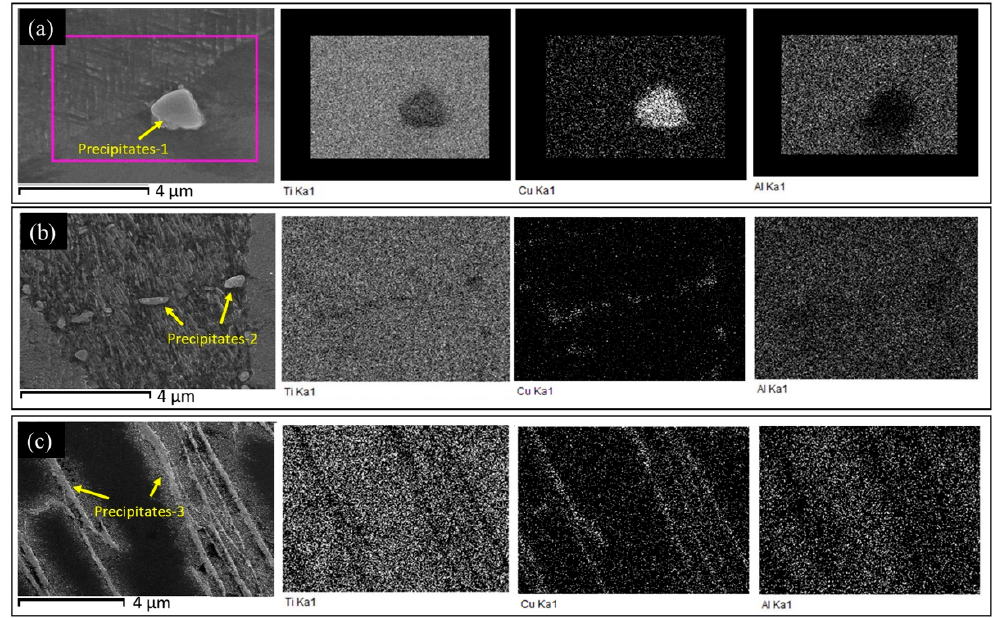
Figure 6. Energy dispersive X-ray spectroscopy (EDS) maps of the specimens annealed at ( a ) 720 °C, ( b ) 920 °C, and ( c ) 1040 °C for 24 h. Table 1. Chemical compositions of the precipitates investigated by EDS, as marked in Figure 6 (wt%). Heat